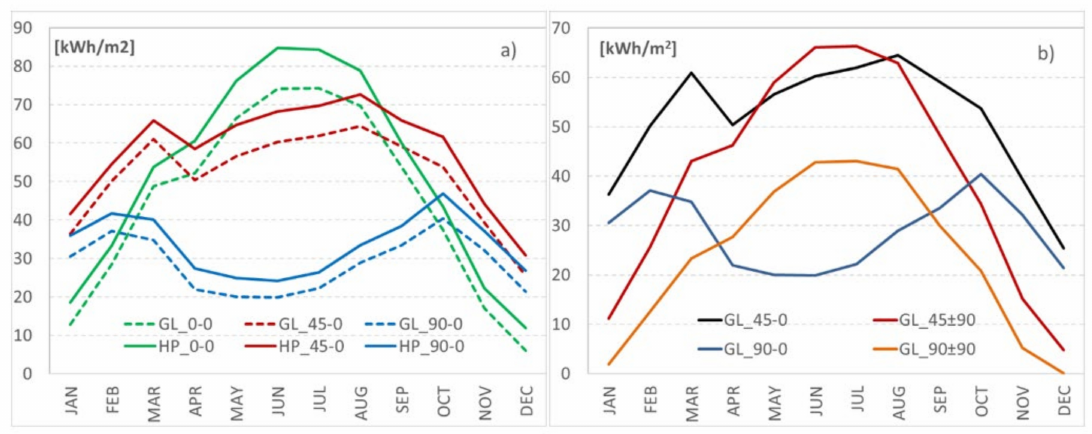
Figure 9. Monthly averaged contribution to domestic heat water (DHW) production and heating for ( a ) glazed collectors (dashed lines) and evacuated tube collectors (continuous lines) with azimuth angle γ = 0 ◦ and di ff erent tilt angles β = 0 ◦ , 45 ◦ , and 90 ◦ ; and ( b ) glazed collectors with azimuth angle γ = 0 ◦ and ± 90 ◦ and tilt angles β = 45 ◦ and 90 ◦ .